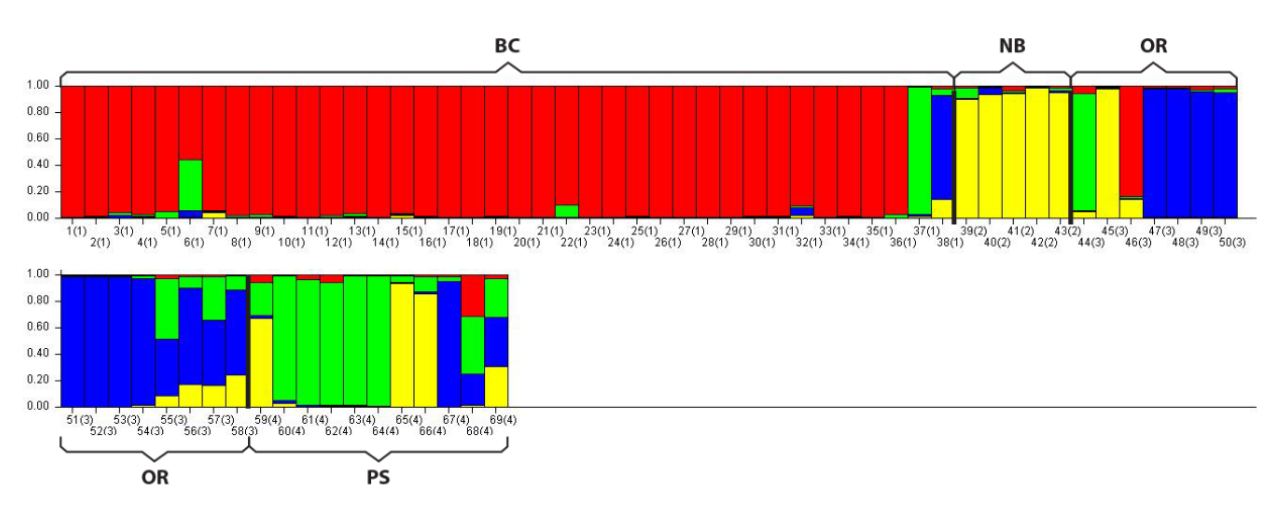
Figure 2. STRUCTURE analysis bar plot. This program assigns unique genetic variation a color code. Populations with one solid color that is not shared by another group are genetically distinct. Populations that share colors are more similar. Note dominant colors in sampled populations: BC = Red; NB = Yellow; OR = Blue; PS = Green. Within PS two individuals were similar to NB (yellow), one was similar to Oregon (blue) and two were a mixture of signatures suggesting geneflow between PS and the other